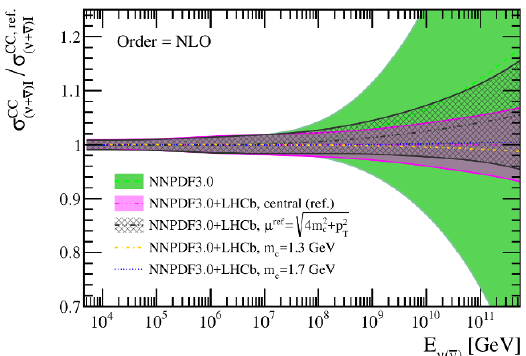
Figure 13 . Comparison of predictions for the CC neutrino-isoscalar cross-section with the NNPDF3.0+LHCb (cid:12)t. The variations have been obtained at NLO accuracy, and di(cid:11)er in the choice of theoretical settings used for the inclusion of the LHCb D -hadron distributions in the PDF (cid:12)t. Each distribution is normalised with respect to the central value of the nominal choice of p (cid:22) ref = m 2 + p 2 c T